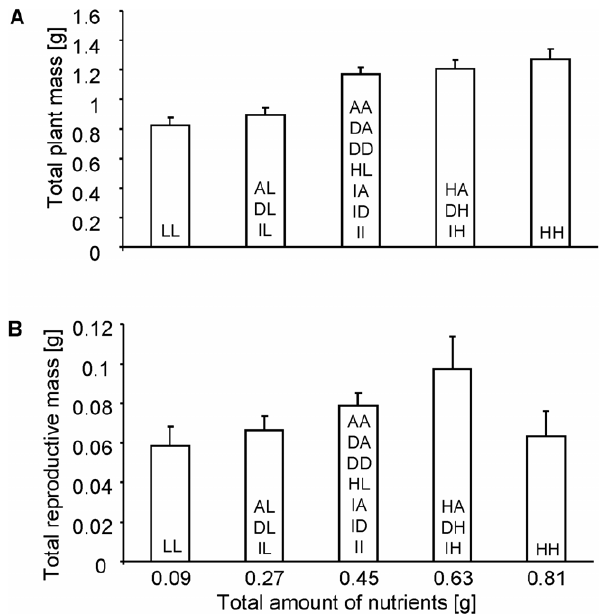
Figure 1. The effect of total nutrient availability on total and reproductive mass. Total plant (a) and reproductive (b) biomass as a function of the total amount of nutrients each plant received throughout the entire experiment. Nutrients were supplied as 20-20- 20 fertilizer (for more data see the Materials and Methods). Data presented are for the final harvest. Treatments contributing to each bar are indicated within it. Nutrient regimes: INC (I), DEC (D), HIGH (H), AVE (A), LOW (L). Values are means 6 1 S.E.